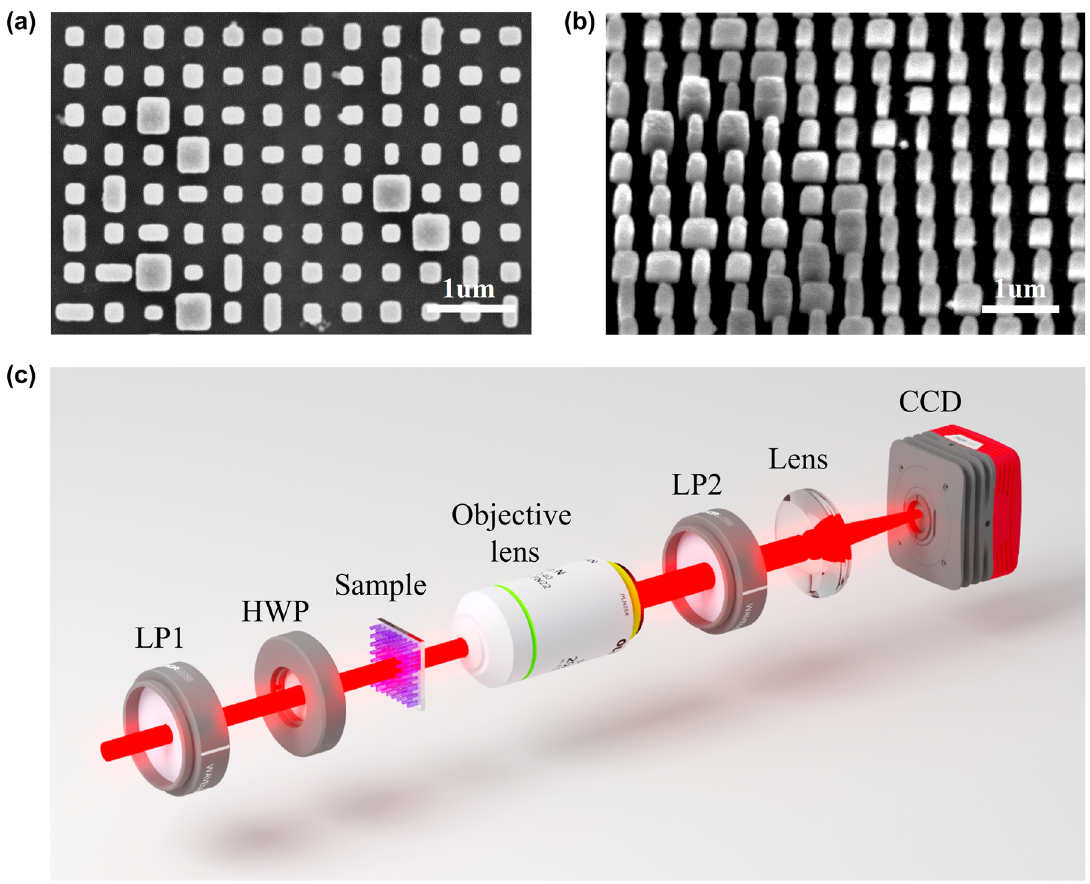
Figure 3: Sample fabrication and experimental setup. (a) and (b) The scanning electron microscopy images of our fabricated metasurface from top and side view. The metasurface is composed of 1000 × 1000 supercells. (c) The experimental setup for capturing the reconstructed holographic images at the Fourier